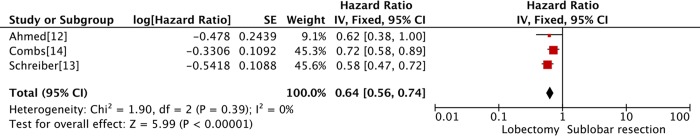
Forest plots of HR for OS with respect to lobectomy versus sublobar resection.OS: overall survival; CI: confidence interval; SE: standard error; IV: inverse variance method.